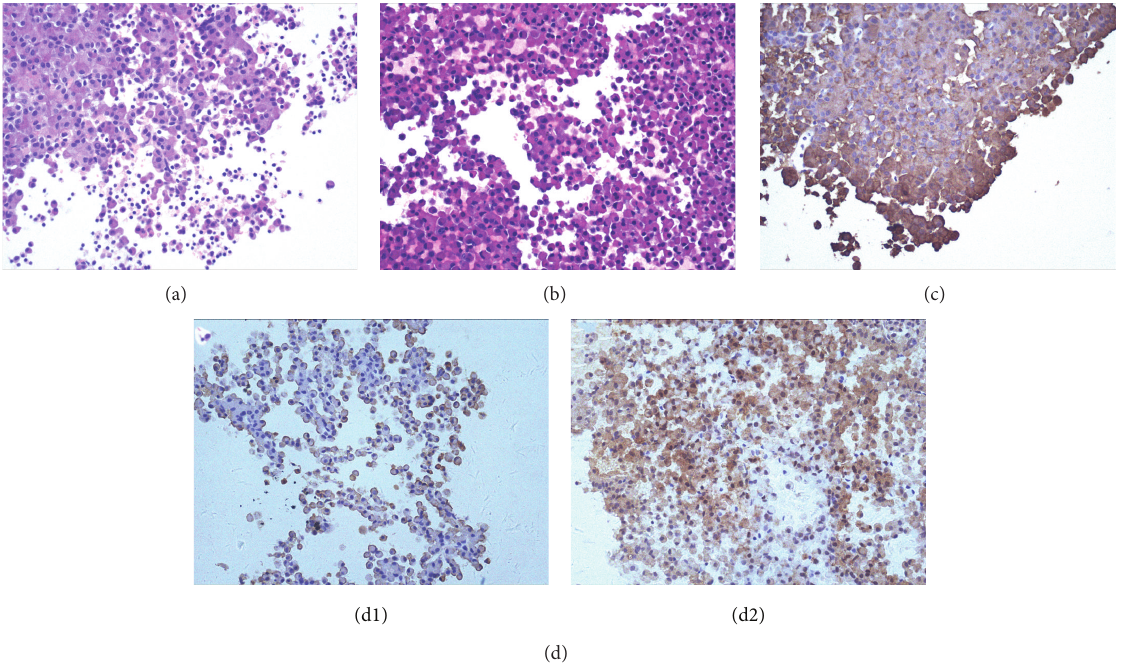
Figure 2: Surgical pathology analyses of the tumors. (a) H&E staining of tumor tissue from a patient in the CD group. (b) H&E staining of tumor tissue from a patient in the CD + PRL group. (c) Immunohistochemistry: cells of the adenoma from a patient in the CD group were immunoreactive to antibodies against ACTH. (d) Immunohistochemistry: cells of the adenoma from a patient in the CD + PRL group were immunoreactive to antibodies against ACTH (d1) and PRL